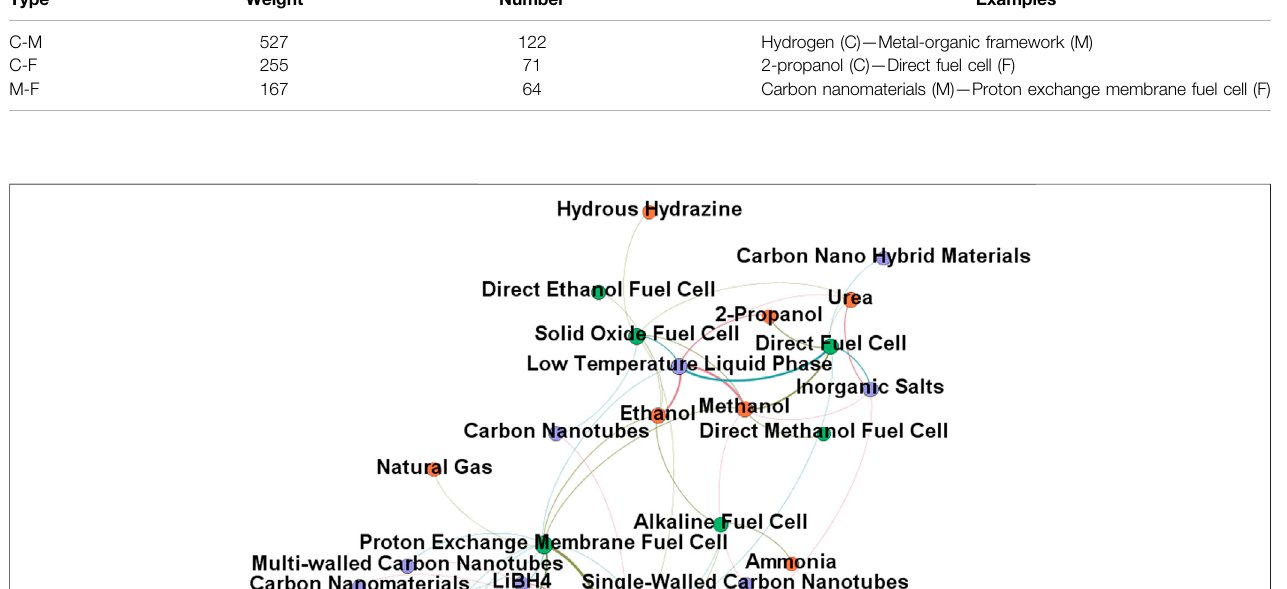
Frontiers in Energy Research |